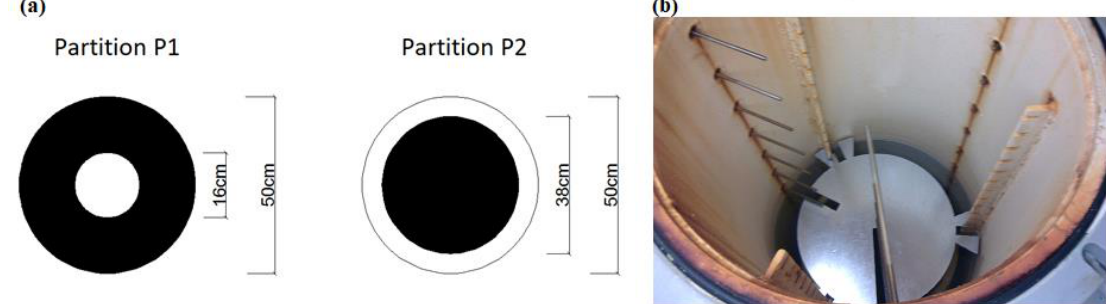
Figure 5. Schema of the horizontal partitions located in the hot water tank ( a ) and view of partitions during installation in the tank ( b ).